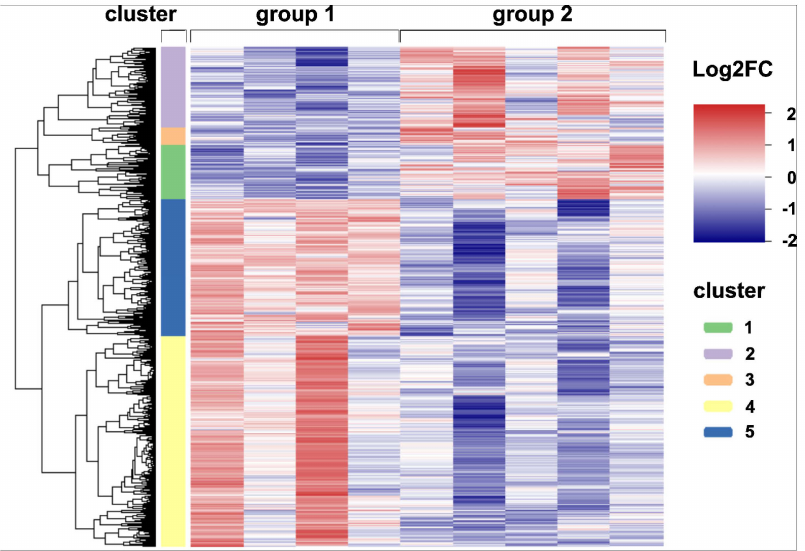
Figure 7. Global gene expression analyses. A heatmap illustrating the differences in expression of 3252 differentially expressed genes (DEGs) detected by pairwise comparisons of lung tissue of uninfected and CDV-infected dogs ( p < 0.05). The color scheme demonstrates normalized gene expression z-score values ranging from − 2 (relative low expression, in blue) to 2 (relative high expression, in red). DEGs were subdivided into five clusters with distinct expression profiles: Clusters 1–3 (green, purple and orange bar) contain upregulated genes (Log2FC > 0), whereas clusters 4 and 5 (yellow and blue bar) show downregulated genes (Log2FC < 0) in CDV-infected dogs. Groups: 1 = uninfected control lung; 2 = acute CDV